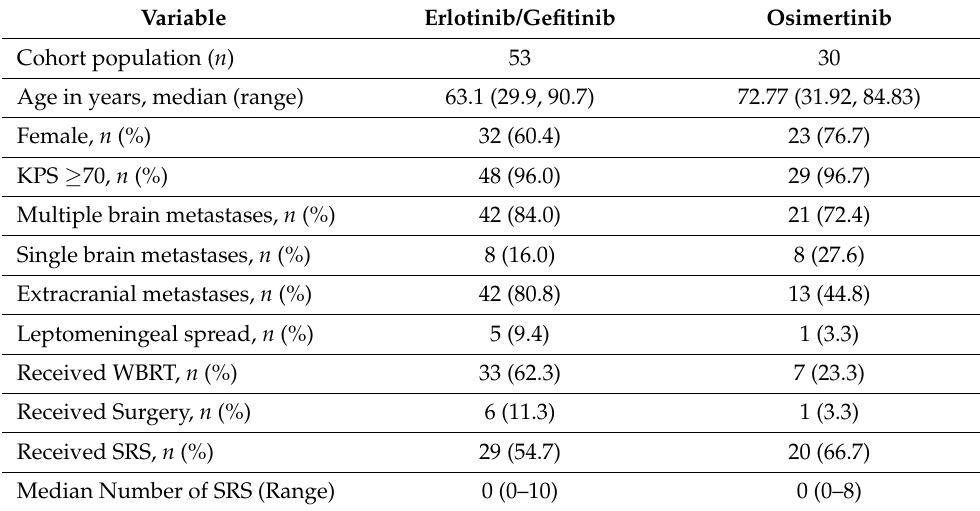
Table 2. Characteristics of patients with NSCLC brain metastases who received EGFR-directed Tyrosine Kinase Inhibitors (EGFR-TKIs) in the first-line setting.